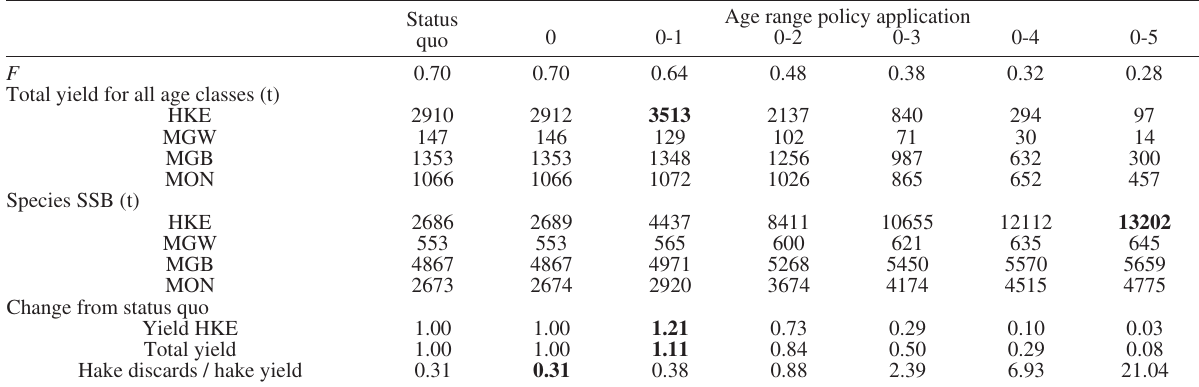
Table 3. – Effects on the SIHS fishery of a ban on sales of juveniles. Yield of each species represents the stationary value of the catches in weight (without discards) as defined under the ban on sale scenario (Eq. 4). Total yield represents the stationary value of the sum of valid catches of all species (without discards). All the values are calculated for the optimal F under each scenario. The status quo scenario is the situation in which all captures can be sold. Values in bold represent the best scenario for each variable.